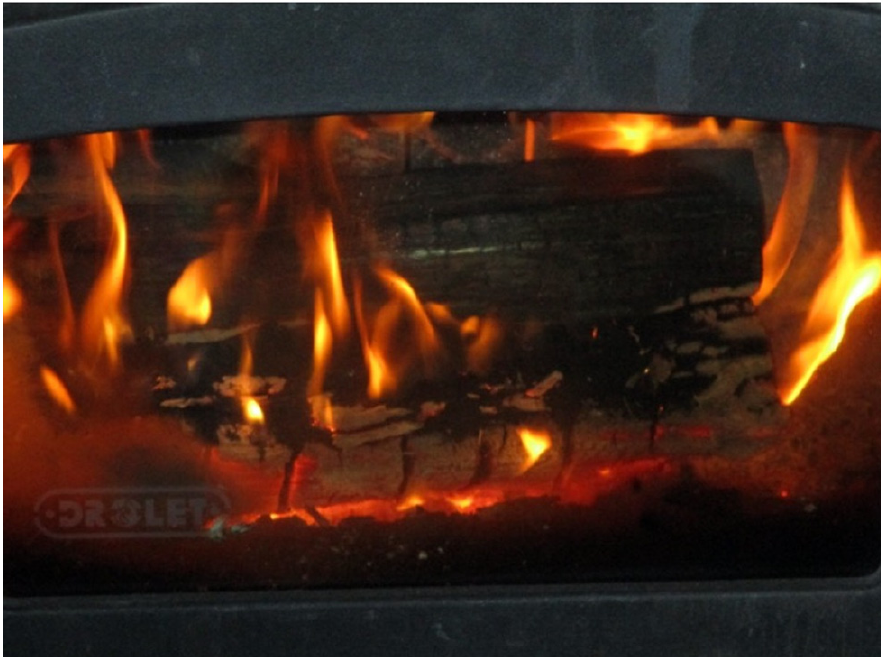
Figure 1. “My Daily Reminder.” This photo is of the participant’s wood stove. It reminds him of learning about the Sacred Fire that helped him put substance use aside.